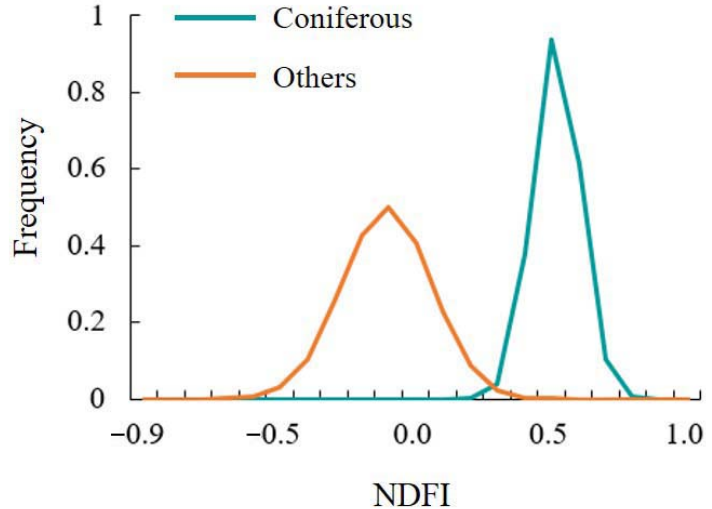
Figure 5. Probability density curves of coniferous and other forest type.